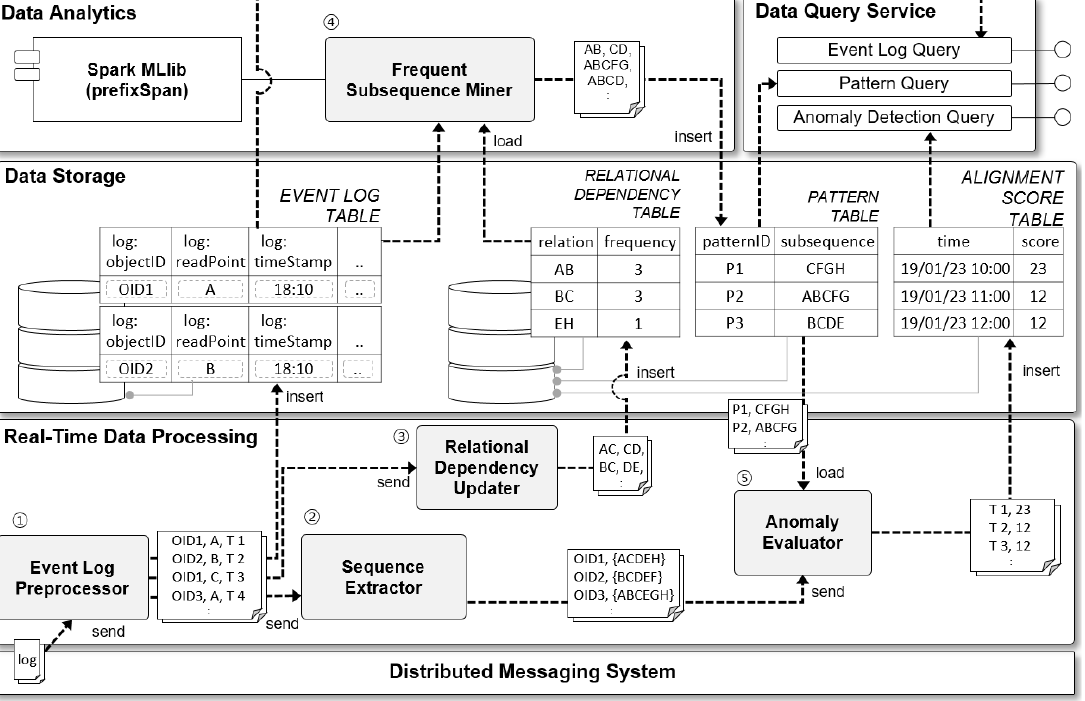
Figure 1. Scalable On-line Process Anomaly Detection System Architecture.